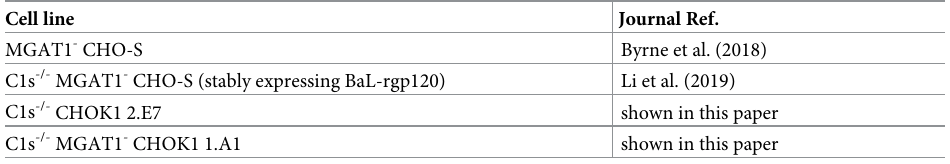
Table 6. CRISPR-Cas9 gene edited CHO cell lines for the expression of recombinant